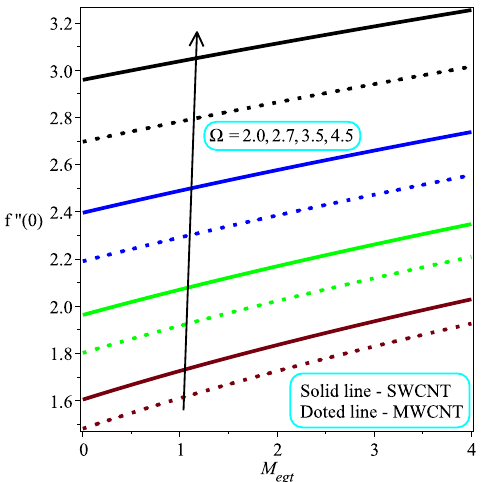
Figure 10. Repercussion of ω with κ = 2, Ω = 3, φ = 0.1 on the local skin friction field.